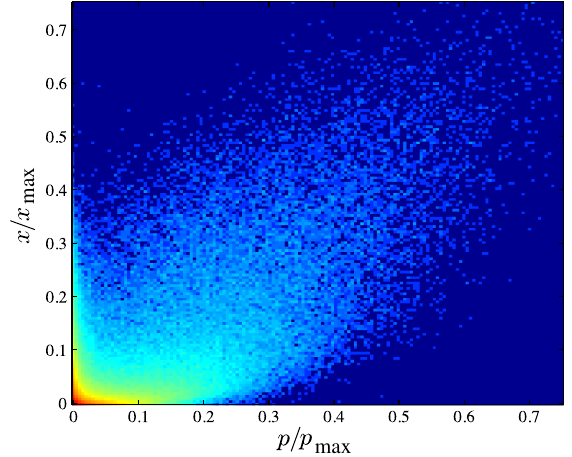
FIG. 1. The joint density of x and p for D ¼ 2 = 3 , 10 6 particles and t ¼ 10 6 . This scatter plot of phase space shows correlation between x and p and rare events with large fluctuations both for x and p .